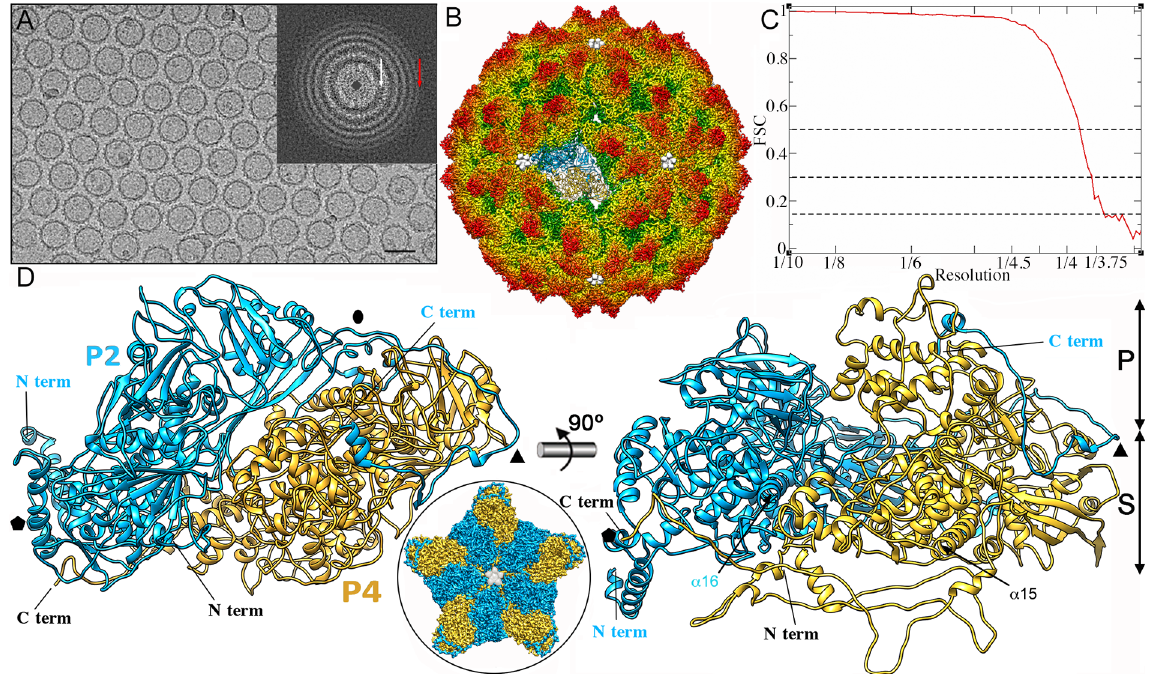
Fig 1. Three-dimensional cryo-EM reconstruction of RnQV1 virions at 3.7 Å resolution. (A) Cryo-EM image of RnQV1. Bar = 500 Å . Inset, power spectrum of a motion-corrected, averaged image. The first Thon ring is at 8.7 Å (white arrow) and the highest visibleThon ring is at 3.4 Å resolution(red arrow). (B) Radiallycolor-coded atomic model of the RnQV1 capsid viewedalong a two-fold axis. The atomic structures of a dimer of P2 (blue) and P4 (yellow) are shown. (C) Fourier shell correlation(FSC) resolutioncurve for RnQV1. Resolutionbasedon the 0.5, 0.3 and 0.143 criteria is 3.88, 3.80 and 3.70 Å respectively. (D) Ribbon diagrams of P2 (blue) and P4 (yellow)(top view, left; side view, right). N and C termini and CP domains(shell, S; protruding, P) are indicated.Symbolsindicate icosahedral symmetry axes. Inset, atomic model of the RnQV1 capsid pentamer viewedalong an icosahedralfive-fold axis, showingthe five P2 (blue) and P4 (yellow) proteins.